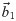
Sketch of a hybrid magnetoreceptor.The magnetic field at the cryptochrome position, B1 can be strongly amplified if the external field b→1 is applied along the line connecting the cryptochrome position and the centre of the particle.